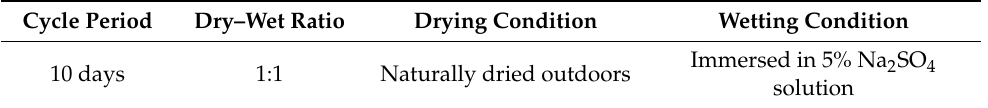
Table 6. Drying–wetting cyclic test